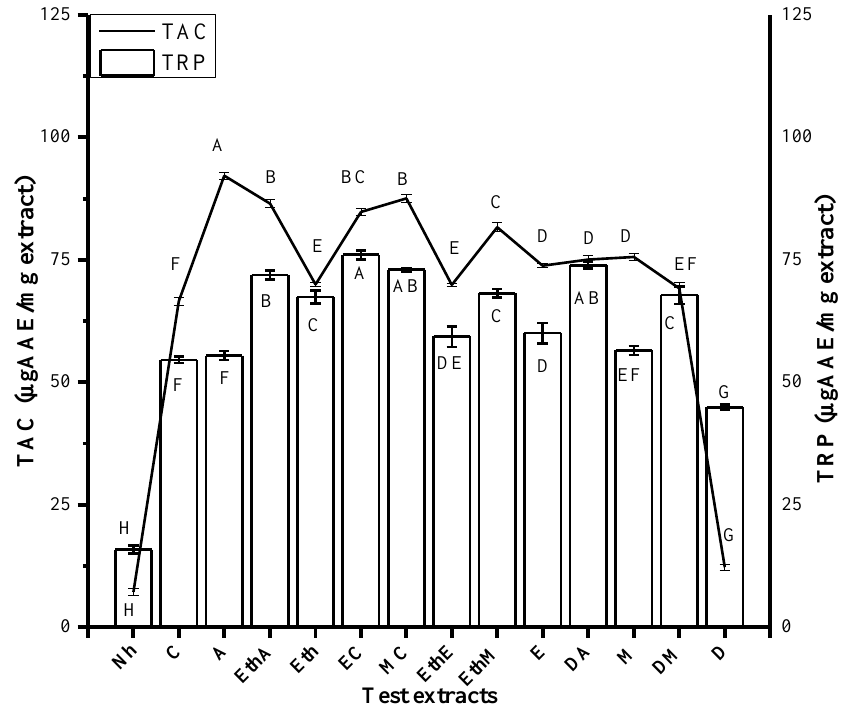
Figure 4. TAC (total antioxidant capacity; mean ± standard deviation) and TRP (total reducing power; mean ± standard deviation) results are displayed after experimenting thrice. a – f represent the significance of results. Samples that display different alphabets were significantly different at p < 0.05.